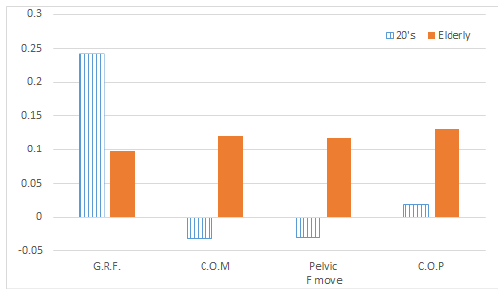
Figure 10. Muscle factor.